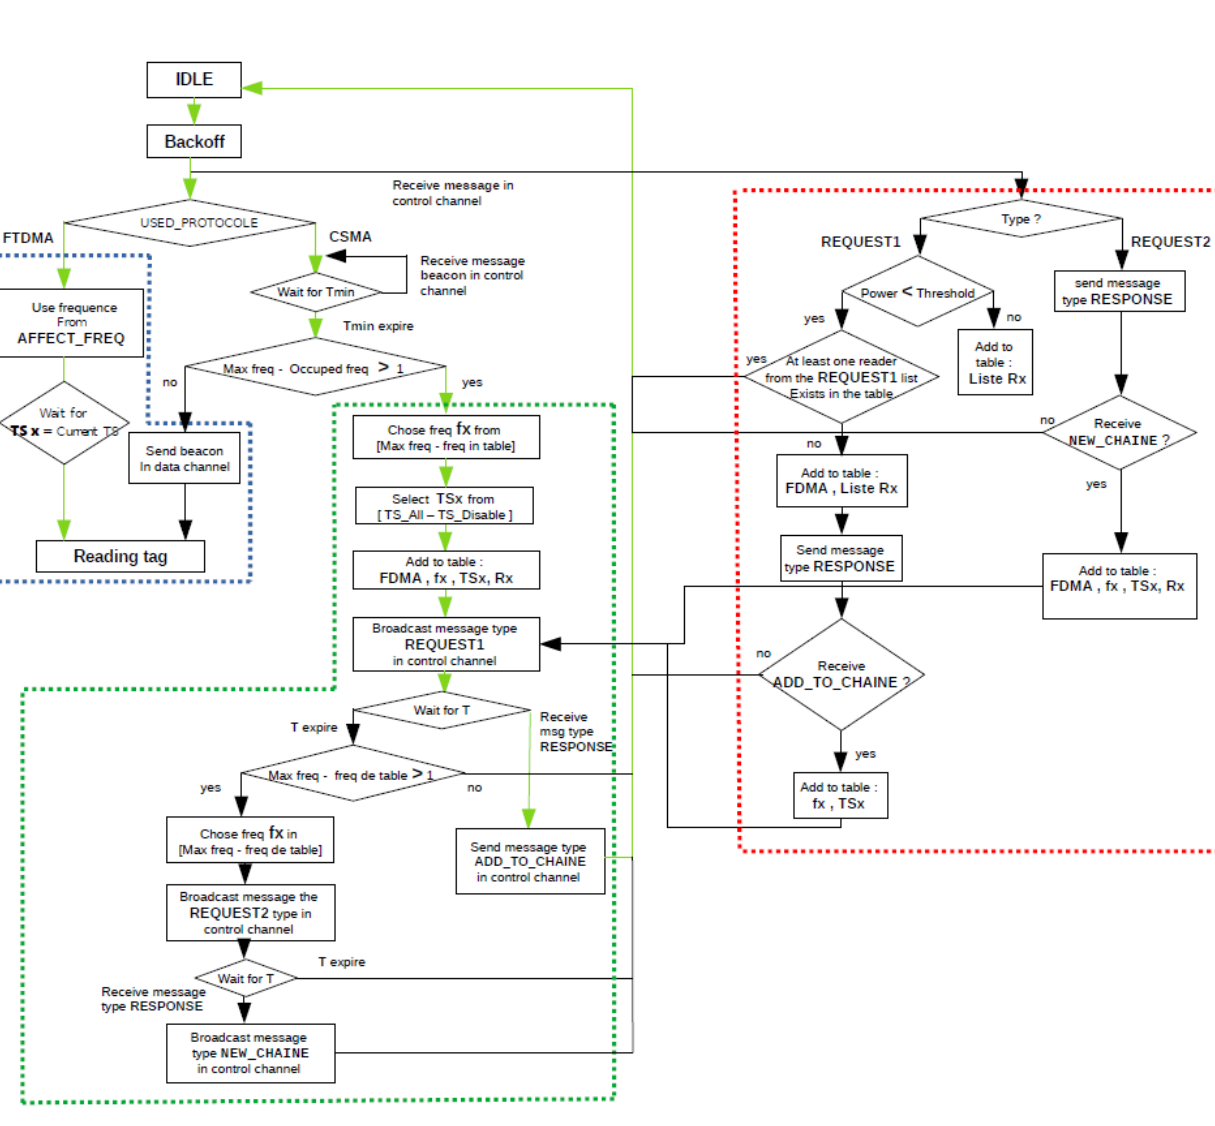
Figure A1. R1 process.